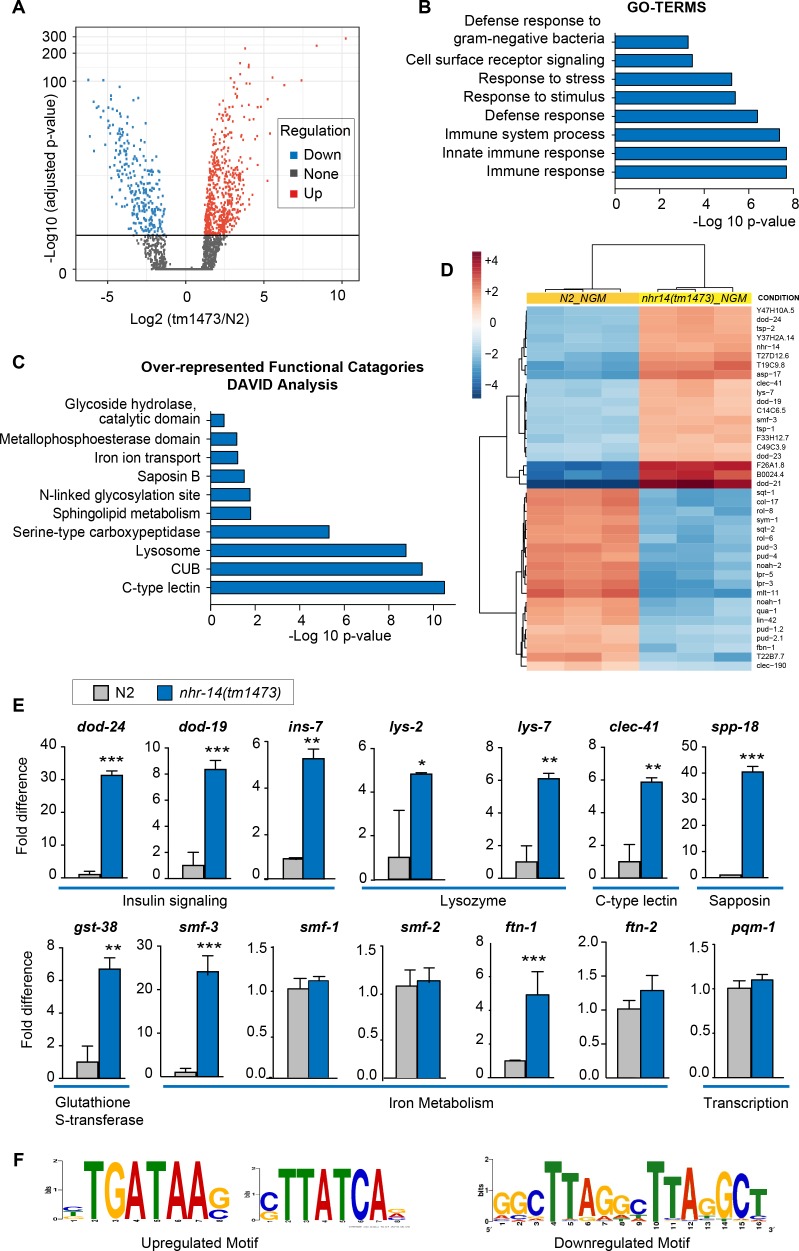
NHR-14 loss of function regulates an innate immune transcriptional program.(A) Volcano plot of differentially transcribed genes in nhr-14(tm1473) mutants normalized to wild-type N2. The x-axis denotes the fold-changes and the y-axis denotes -log10 of wald test adjusted p-values. The horizontal line represents the p-value threshold of <0.05. (B) Gene ontology (GO) analysis of genes that are upregulated in nhr-14(tm1473) mutants normalized to wild-type N2 worms. (C) DAVID analysis for over-represented functional categories of upregulated genes in nhr-14(tm1473) mutants normalized to wild-type N2 worms. (D) Heat map showing the top 20 upregulated and 20 downregulated genes that are differentially expressed between nhr-14(tm1473) mutants and wild-type N2 worms. The columns represent three biological replicates of wild-type N2 and nhr-14(tm1473) mutants, and the rows represent individual genes. (E) qPCR validation of selected innate immune and iron-related genes that are upregulated in nhr-14(tm1473) mutants (n ≥ 3 biological replicates). Values are expressed as fold difference compared to wild-type N2 worms ± SEM and compared by unpaired two-tailed Student’s t test *p<0.05, **p<0.01, ***p<0.001. (F) Motif enrichment analysis for upregulated and downregulated genes in nhr-14(tm1473) mutants.10.7554/eLife.44674.013Figure 5—source data 1.Overlap between upregulated and downregulated nhr-14(tm1473) genes with published C. elegans tissue-specific expression datasets using WormExp v1.